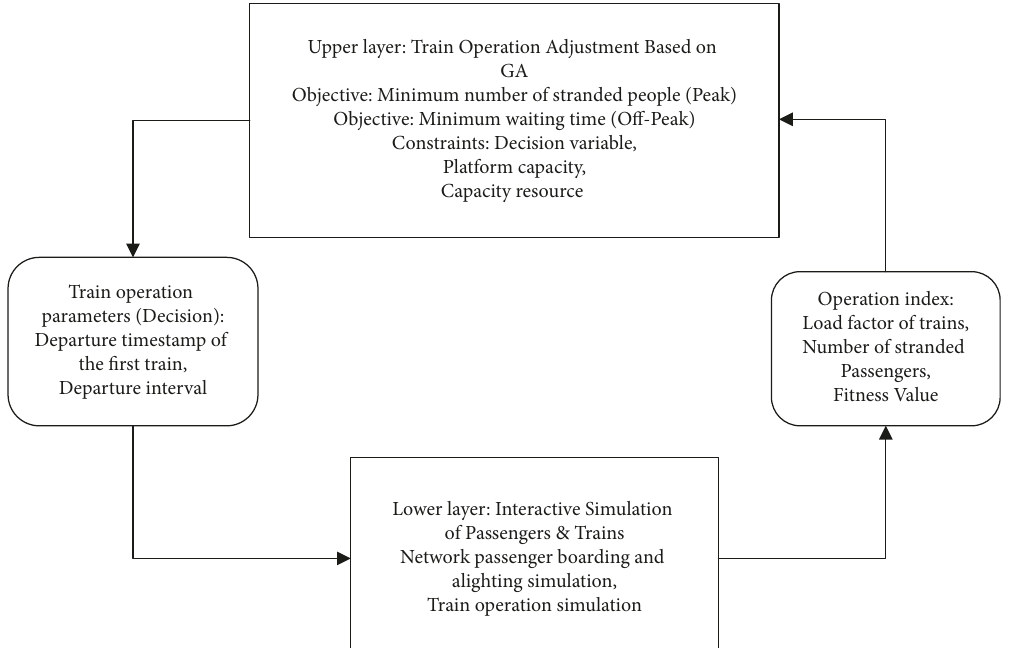
Figure 2: Structure of the two-level algorithm for peak and off-peak periods.